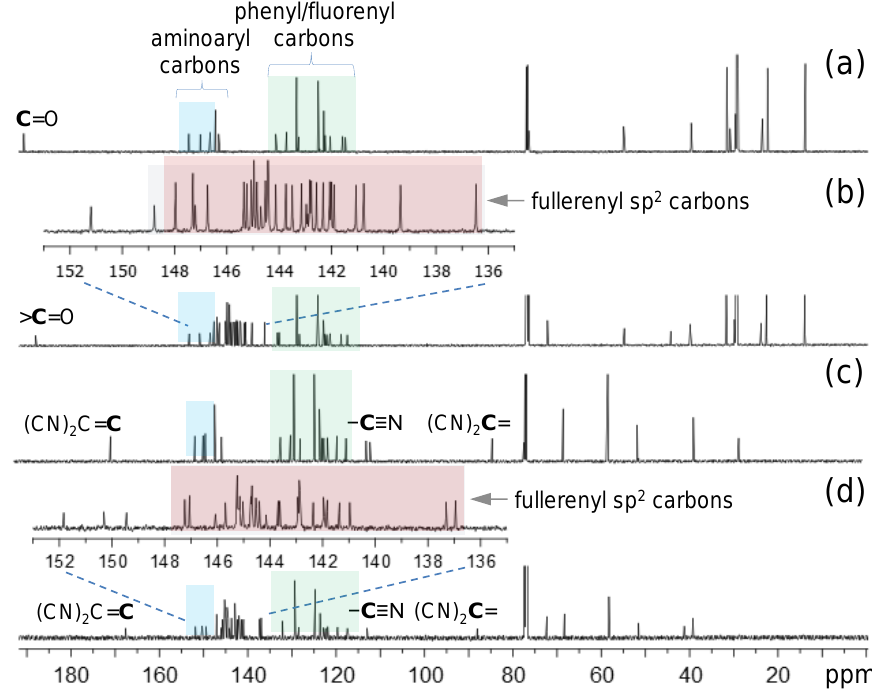
Figure 2. 13 C-NMR spectra of ( a ) BrDPAF-C and ( d ) C (>CPAF-C ) 2 with three regions of carbon peaks marked by blue, green, 60 2M and